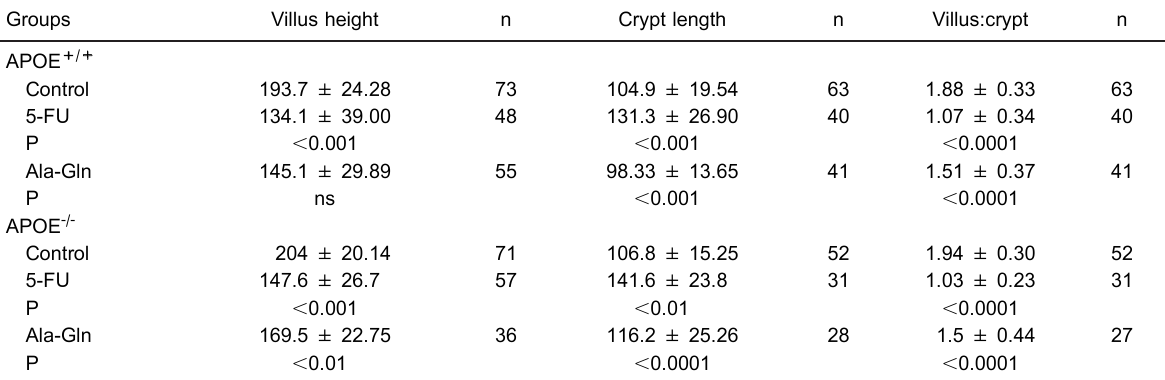
Table 3. Intestinal morphometry from experimental mice. Groups